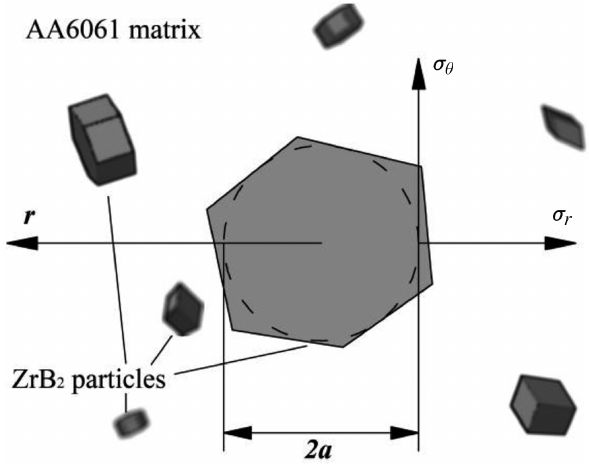
Figure 9: Graph of thermal stress at matrix – particle interface in the composite.